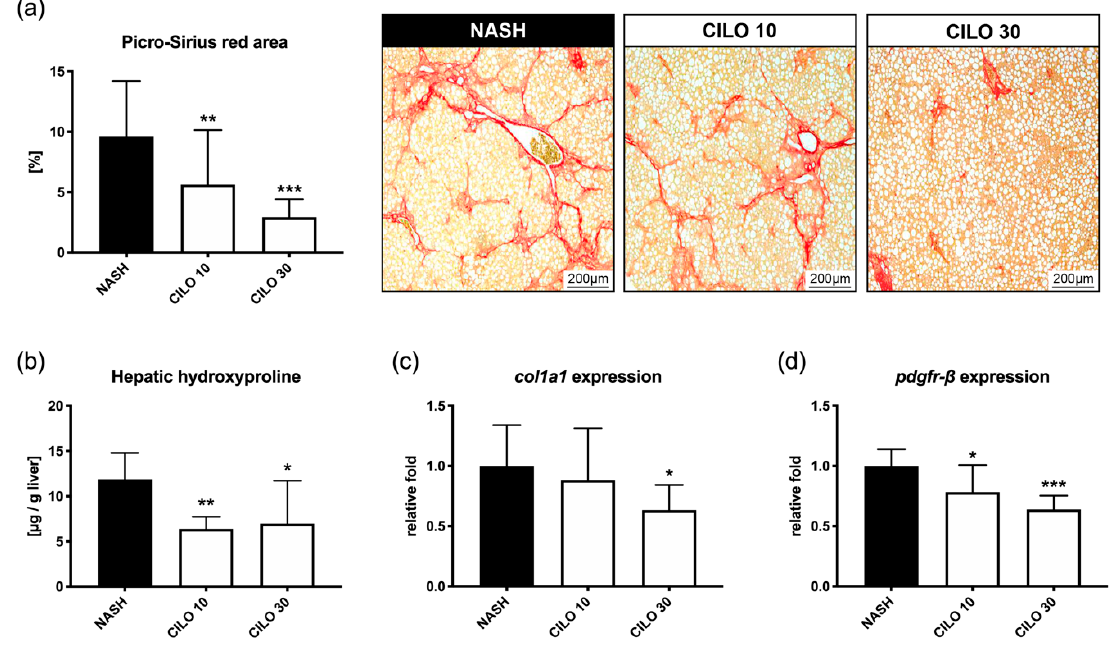
Figure 2. Cilofexor exerts dose-dependent anti-fibrotic properties. ( a ) The anti-fibrotic effects of FXR agonism with cilofexor (CILO) correlate with a dose-dependent decrease in Picro-Sirius red-stained area of liver sections. ( b ) Similarly, hepatic hydroxyproline content was significantly reduced in cilofexor-treated rats. In line with this, expression of ( c ) col1a1 and ( d ) pdgf- β are lowered by FXR agonism. * p < 0.05, ** p < 0.01, *** p < 0.001 vs. NASH (10-week model); two-sided unpaired t -test; n = 7 per group.